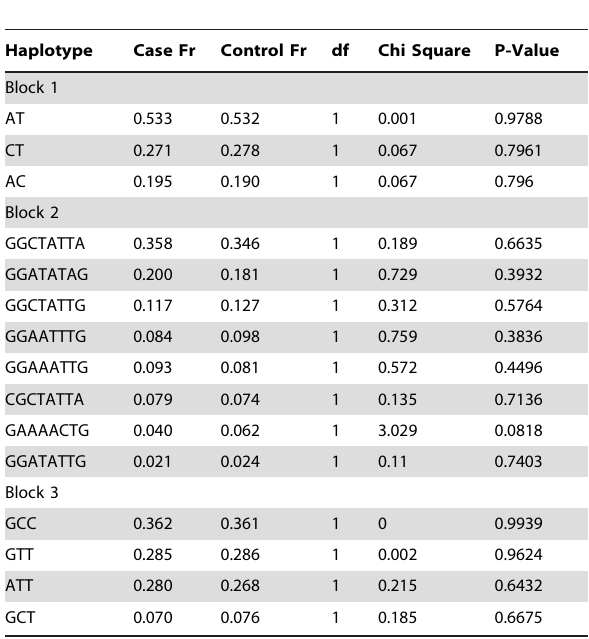
Table 4. Haplotype frequencies and AR